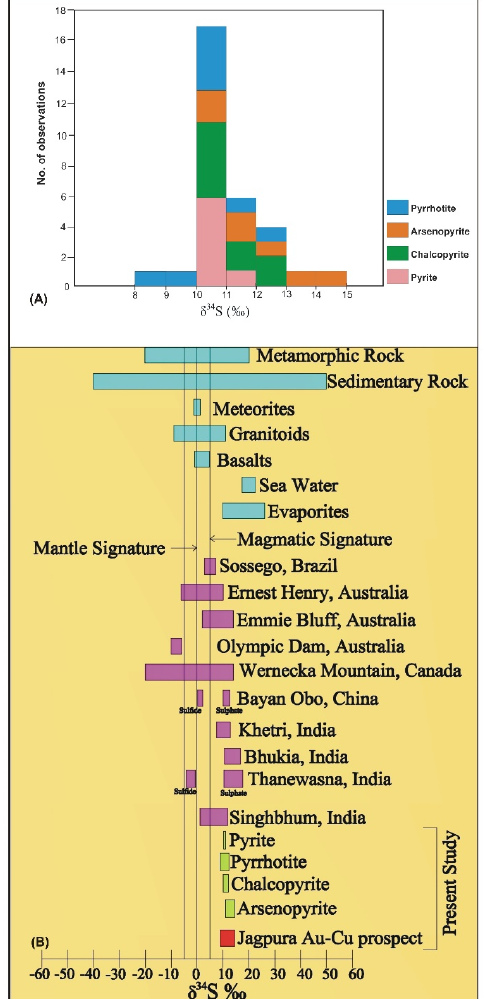
Figure 14. Sulfur isotope compositions of different sulfide minerals from the Jagpura deposit: ( A ) Histogram showing values of various sulfide minerals; ( B ) Range of δ 34 S for magmatic, sedimentary, metamorphic, seawater and evaporite systems from references [59,82]. Plot showing the variation in δ 34 S values of sulfides from the Jagpura IOCG deposit, and comparison of the δ 34 S values of sulfides from the Jagpura deposit with major geological sulfur reservoir and with various IOCG deposit worldwide from reference [24,83] and India from references [27,28,31,39,44,84]. The major gold bearing sulfide mineral within the Jagpura Au-Cu deposit is arseno- pyrite and it contains a higher isotopic ratio than the other sulfide phases. The higher isotopic range in the sulfur isotope compositions imply that sulfide minerals are enriched in heavy isotopes (Figure 14B). In various deposits around the world, isotopically heavy sulfur ( δ 34 S > 5) suggests the presence of non-magmatic sulfur sources. Higher positive values of the sulfur isotope rule out magmatic ( δ 34 S = 05), [85,86], mantle ( δ 34 S = 01), [87], and seawater/biogenic sulfur sources ( δ 34 S = > 20), [83]. The presence of relatively higher δ 34 S rich sulfides indicates that the possible source of heavy sulfurs is (i) seawater, (ii) evaporitic water and (iii) oxidized meta-sedimentary fluids [88,89]. Therefore, the